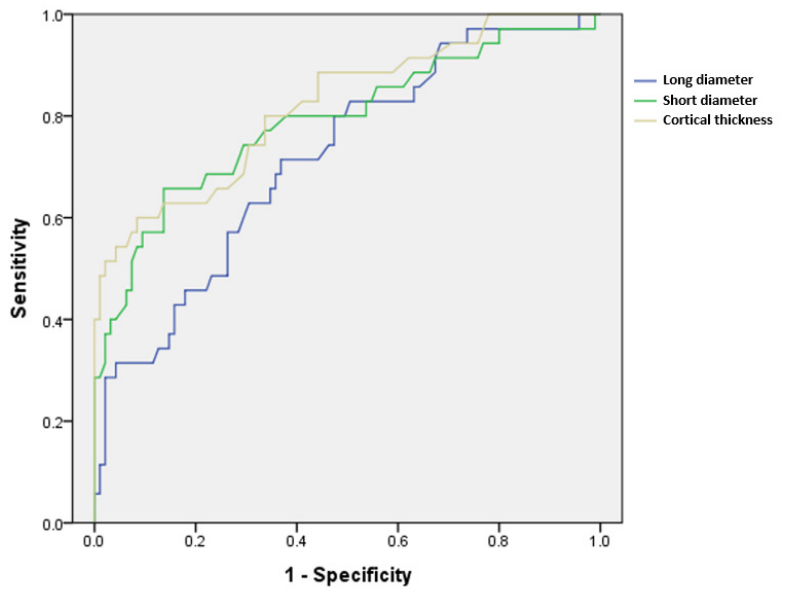
Figure 4. ROC curves of the continuous variables long diameter, short diameter, and cortical thickness, which showed significant differences between metastatic and benign axillary lymph nodes. Table 4. Area under the curve of the ROC curve in Figure 4.